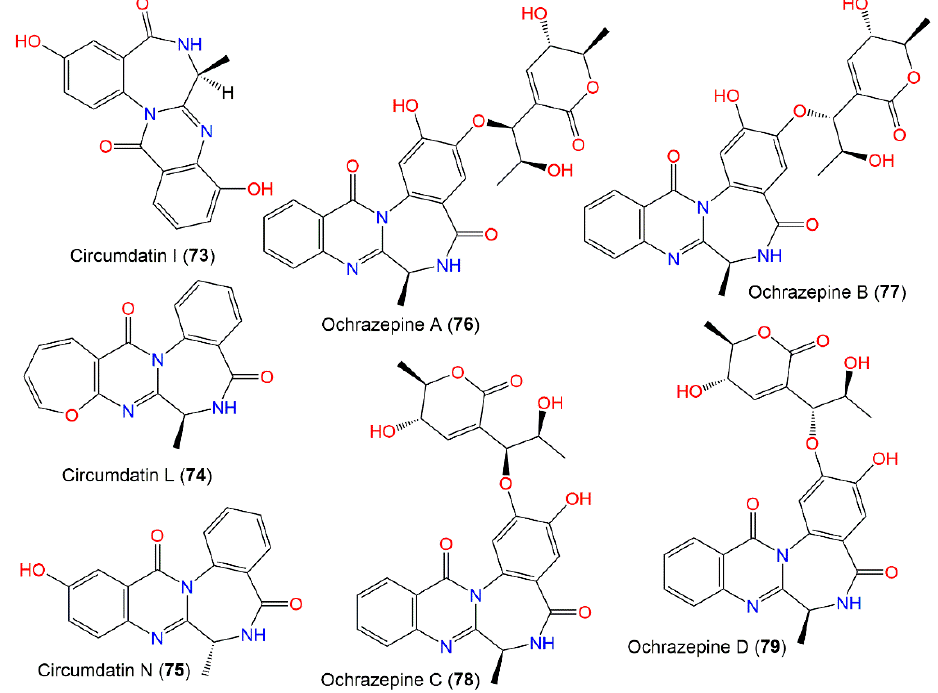
Figure 7. Benzodiazepine derivatives ( 73 – 79 ) reported from A. ochraceus. Their structures and absolute configuration were assured by spectral and chemical methods. These compounds are epimers, differing only in configurations at C-8 (cid:48) . Their cytotoxic potential versus 2 normal and 26 human cancer cell lines was evaluated in the CTG (Cell Titer Glo) assay. Compound 117 had the most broad-spectrum cytotoxic capacity against 16 cancer cells (IC 50 ranged from 2.54 to 9.79 µ M) because the epoxide could alkylate DNA by a nucleophilic addition with the sulfhydryl of protein or the base of DNA. Compound 76 also displayed a wide spectrum cytotoxic potential versus 10 cancer cells (IC 50 ranged from 3.10 to 11.32 µ M). In addition, 67 , 77 , and 79 exhibited a selective cytotoxic capacity versus U251, while 78 selectively prohibited U87, A673, and Hep3B. Interestingly, the conjugation among 67 and 117 promoted the inhibitory potential on U87 and U251. Compounds 76 and 78 with 8 (cid:48) S configuration revealed cytotoxic potential versus U87 cells; however, 77 and 79 with 8 (cid:48) R configuration were active versus U251 cells. On the other hand, 76 – 79 exhibited low cytotoxicity on the normal human cells, HEK-293F and L02. Thus, these metabolites could represent leads in anticancer drugs against human glioblastoma cells with non-cytotoxic action to human normal cells [31].